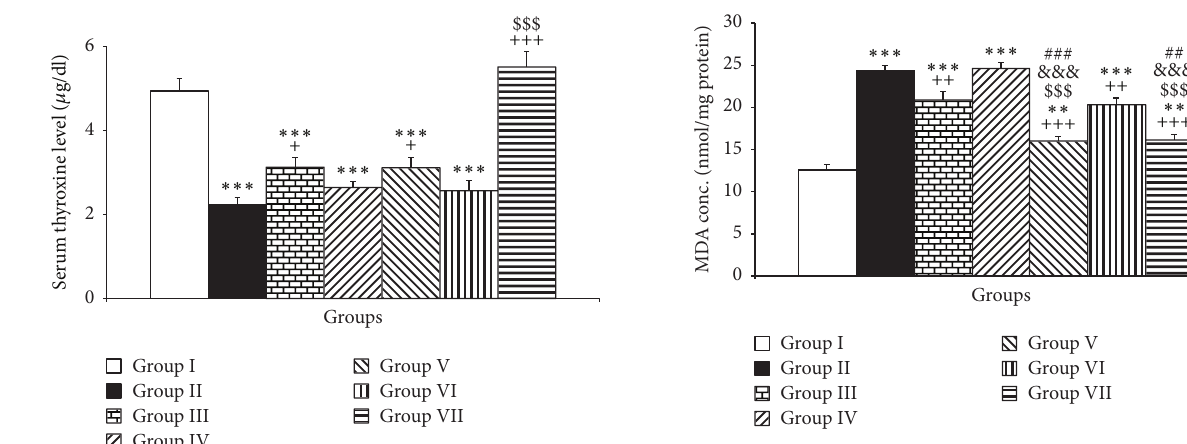
Figure 1: The effects of PTU, Vit E, pioglitazone, and rosiglitazone on serum thyroxine concentrations. Data are presented as mean ± SEM; 𝑛 = 7 . ∗∗∗ 𝑃 < 0.001 versus group I, + 𝑃 < 0.05 and +++ 𝑃 < 0.001 versus group II, and $$$ 𝑃 < 0.001 versus group III. The data from different treatment groups were compared by using one way ANOVA followed by post hoc LSD test. Group I (control), the animals received drinking water; group II, the animals received 0.05% propylthiouracil (PTU) in drinking water; besides PTU, the animals in groups III, IV, V, VI, and VII were injected with 20mg/kg vitamin E (vit E), 10 or 20 mg/kg pioglitazone, and 2 or 4mg/kg rosiglitazone, respectively.